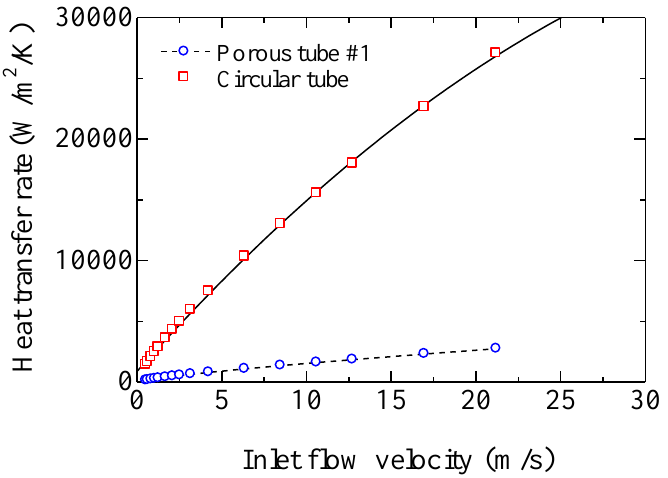
Figure 6. Heat transfer performance of helium gas flow in unidirectional porous tube.